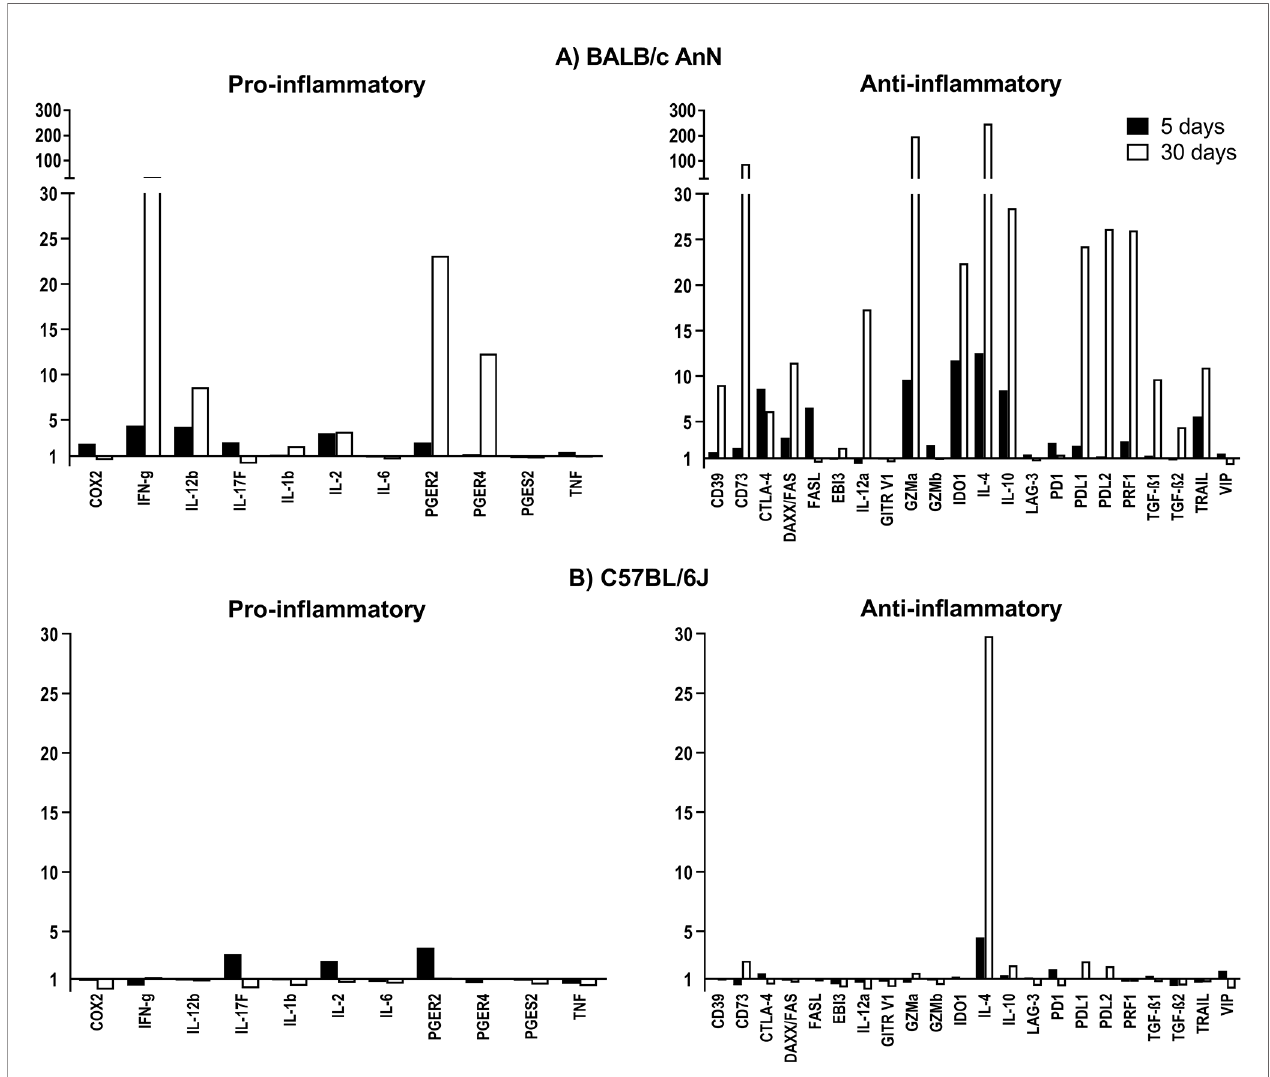
FIGURE 2 | Relative gene expression of molecules involved in the in fl ammatory and regulatory immune response after infection with Taenia crassiceps cysticerci in BALB/cAnN (A) and C57BL/6 (B) mice on days 5 and 30 post-infection. Six infected mice and 6 controls were included for each time point